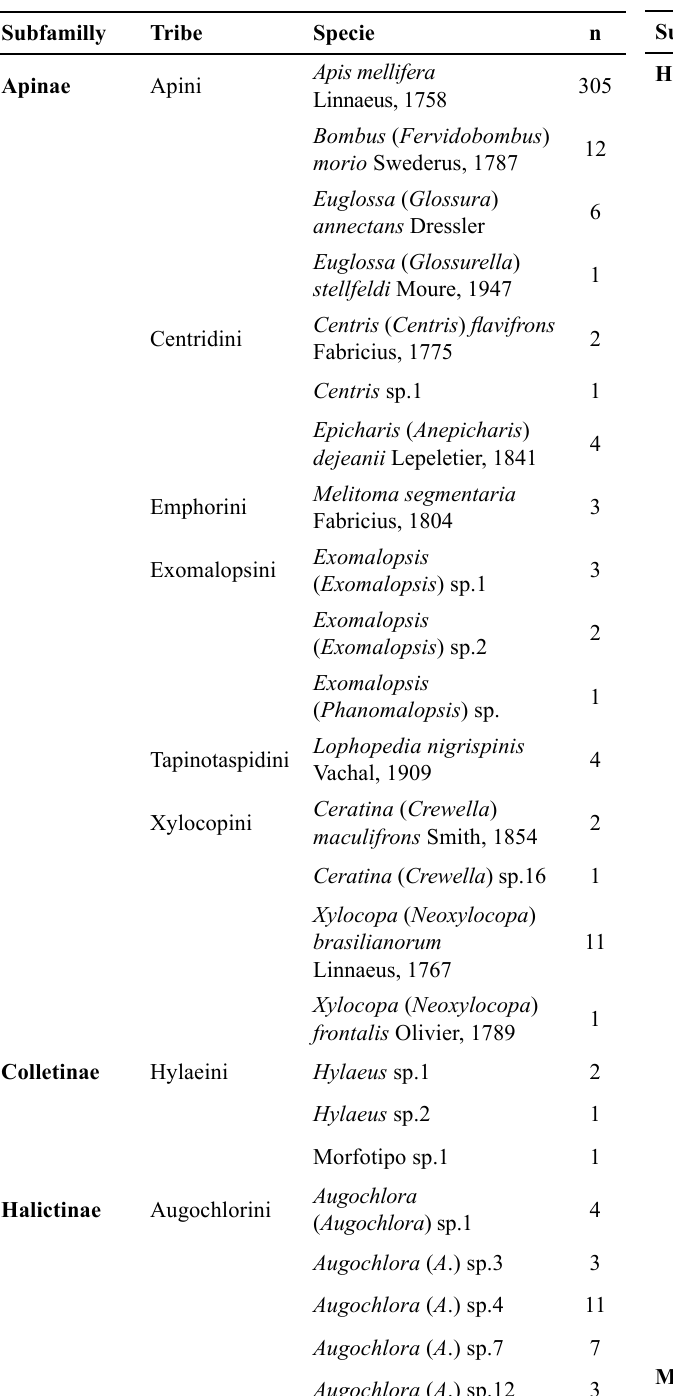
Table 1 . List of bee species from Ilha Grande, São Francisco do Sul, SC, following the classification by Melo & Gonçalves (2005). Caption: n = number of